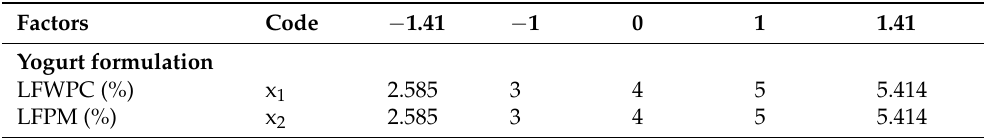
Table 2. Codified variables with variation levels for yogurt